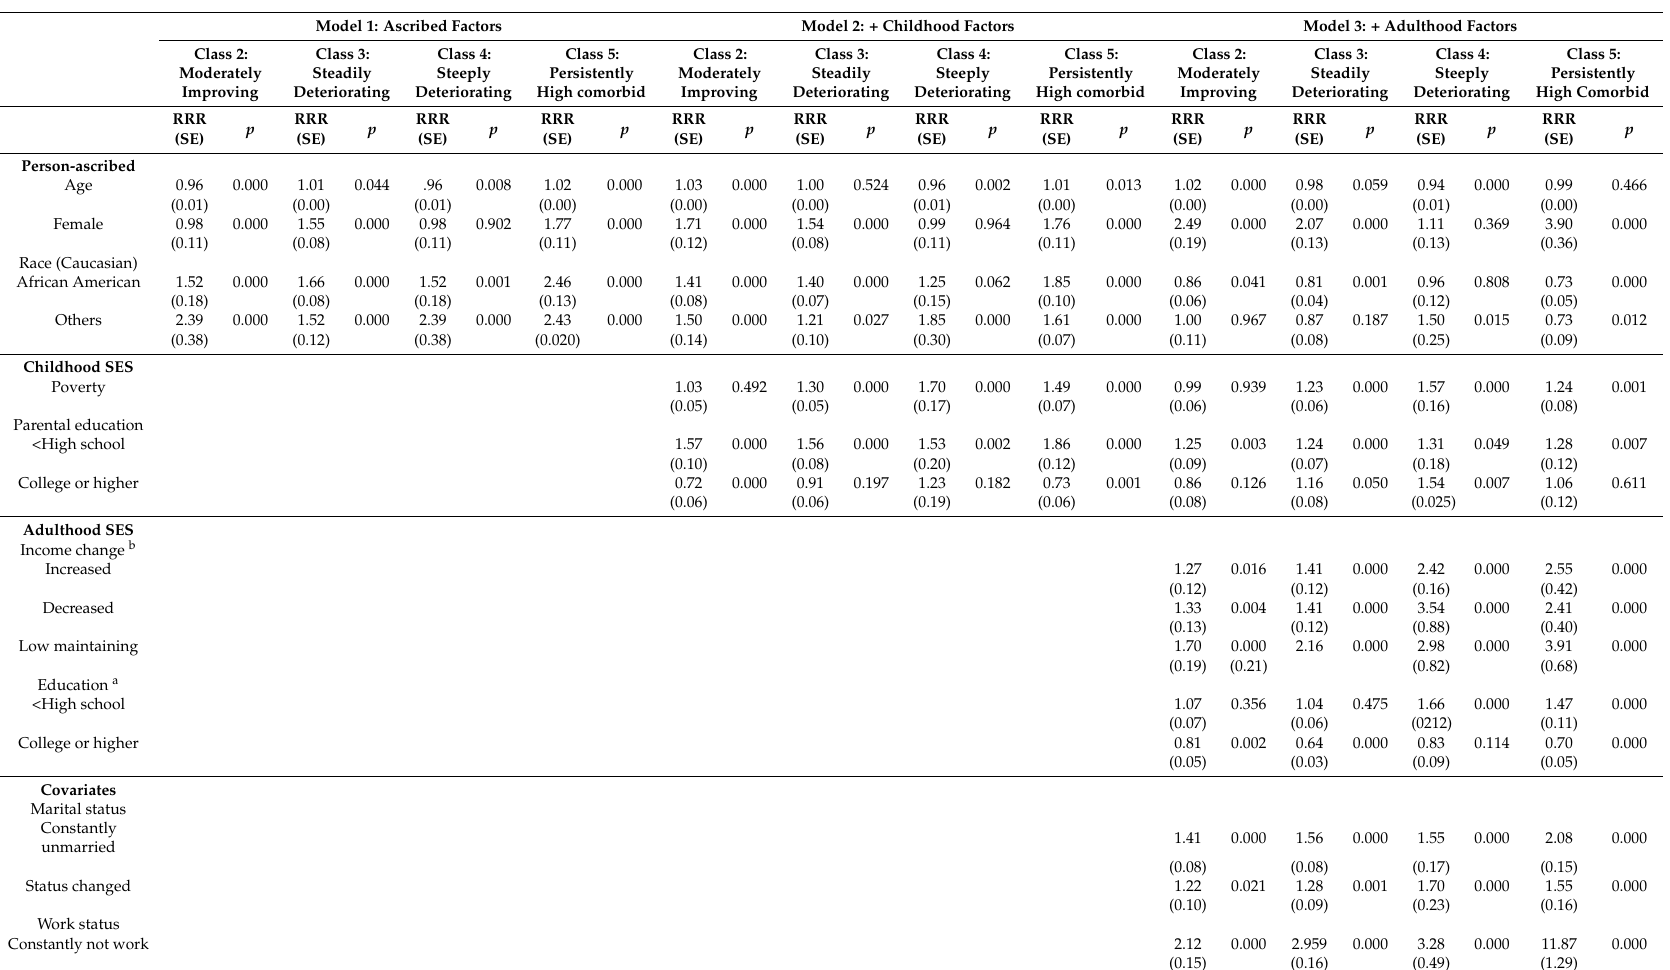
Table 3. Multinomial logistic regression model predicting trajectory